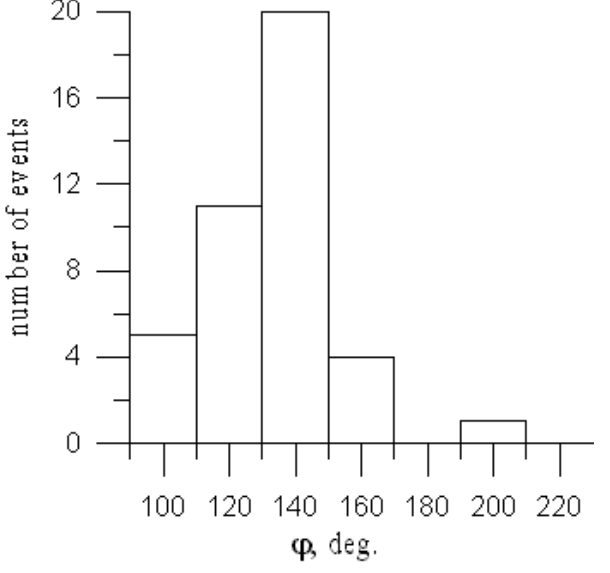
Fig. 4. Distribution of the phase difference between the hm F and f cr variations.